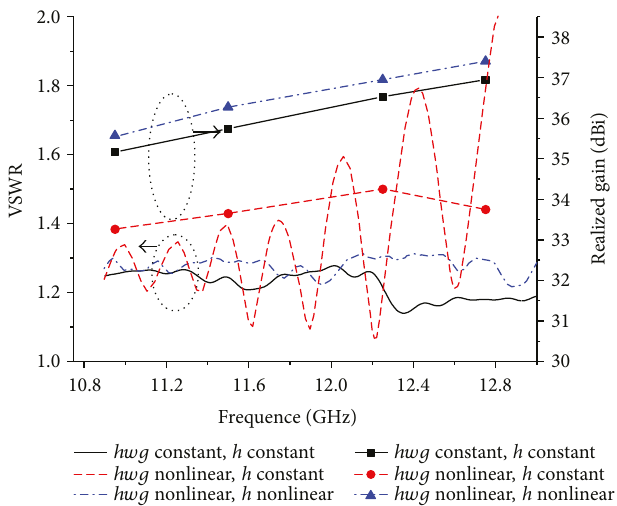
Figure 9: Full-wave simulation results of three di ff erent VICTS